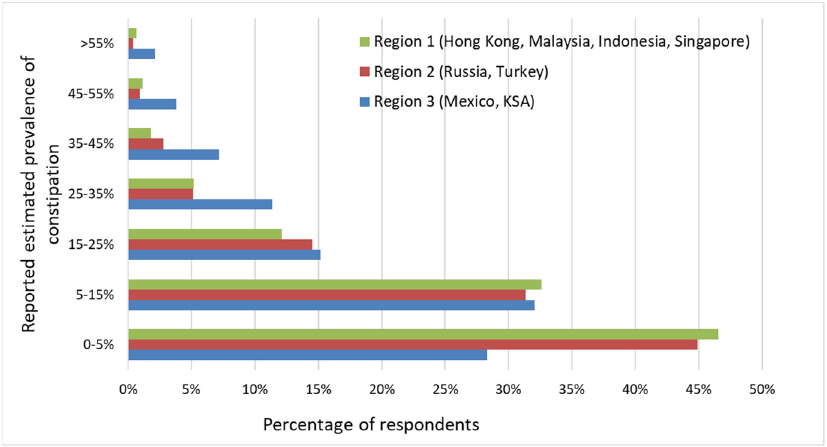
Figure 3. The estimated prevalence of toddler FC by region, reported by the respondents. Data are presented as the percentage of respondents estimating a certain prevalence percentage. Overall, the estimated prevalence was different between regions ( p < 0.001).